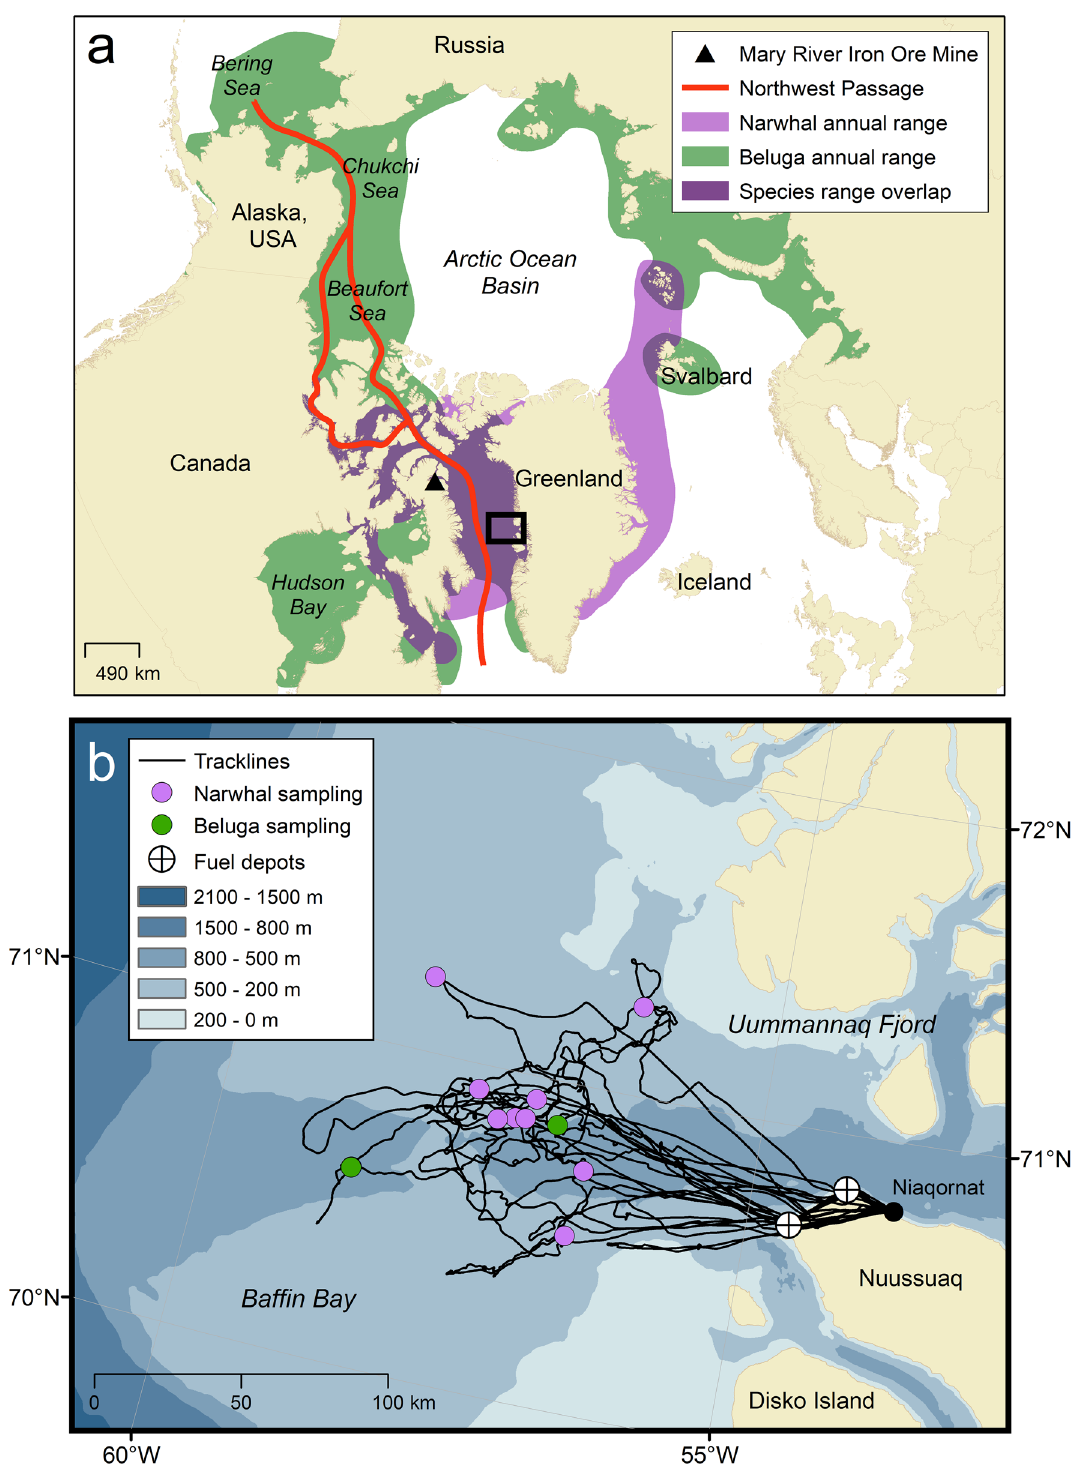
Figure 1. Top panel: map of narwhal (purple) and beluga (green) annual ranges ( a ). Overlapping beluga and narwhal annual ranges is visible in dark purple. The Northwest Passage sea route between the Atlantic and Pacific oceans is shown in red. Bottom panel: map showing track lines of search effort, fuel depots, and recording sites for narwhals and belugas in Baffin Bay, West Greenland, between March 21st and 31st, 2013 ( b ). The black inset box in ( a ) demarcates the area shown in ( b ). Maps were created using ArcGIS’s ArcMap software (v. 10.8; https:// www. esri. com/ en- us/ arcgis/ produ cts/ arcgis- deskt op/ resou